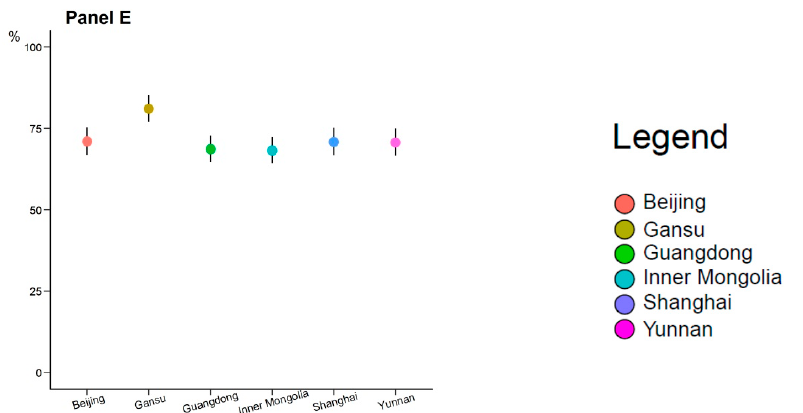
Figure 3. Influenza vaccination attitudes of telephone survey respondents during the October 2017 to March 2018 influenza season in six provinces of China. Panel ( A ) Willingness for influenza vaccination during the 2018/2019 influenza season in China; Panel ( B ) Willingness for influenza vaccination during the 2018/2019 influenza season on the condition that the influenza vaccine was recommended by their doctors; Panel ( C ): Willingness for influenza vaccination during the 2018/2019 influenza season on the condition that the influenza vaccine was free; Panel ( D ): Willingness for influenza vaccination during the 2018/2019 influenza season on the condition that their employer supported the influenza vaccination; Panel ( E ): Willingness for recommendation of influenza vaccination to one’s family members influenza vaccination during the 2018/2019 influenza season.